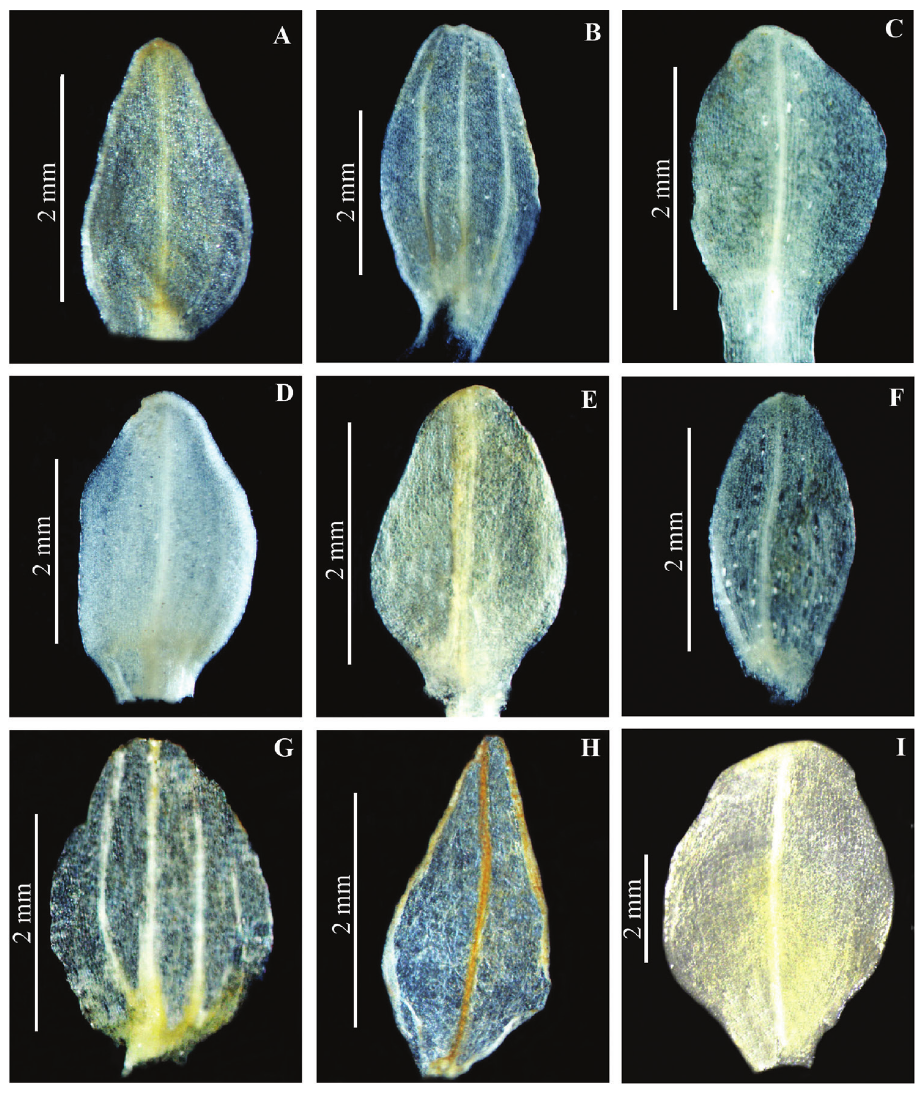
Figure 6. Dorsal sepal of Herminium . A H. monorchis B H. chloranthum C H. pygmaeum D H. josephi E H. monophyllum F H. lanceum G H. macrophyllum H H. glossophyllum I H. coeloceras.